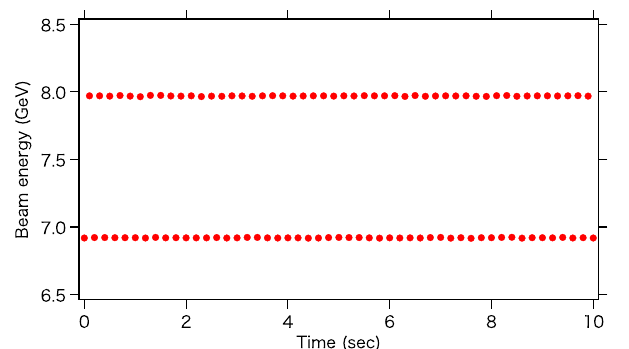
FIG. 3. Beam energies measured at the dispersive chicane of BL3. The bunch repetition was 10 pps and the beam energy was alternately changed between 8.0 and 6.9 GeV.